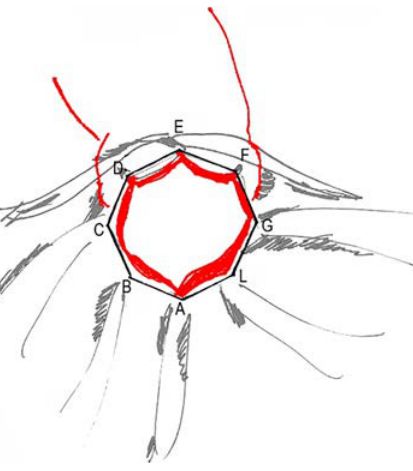
Figure 6 Maximum area in a radial sphincterotomy